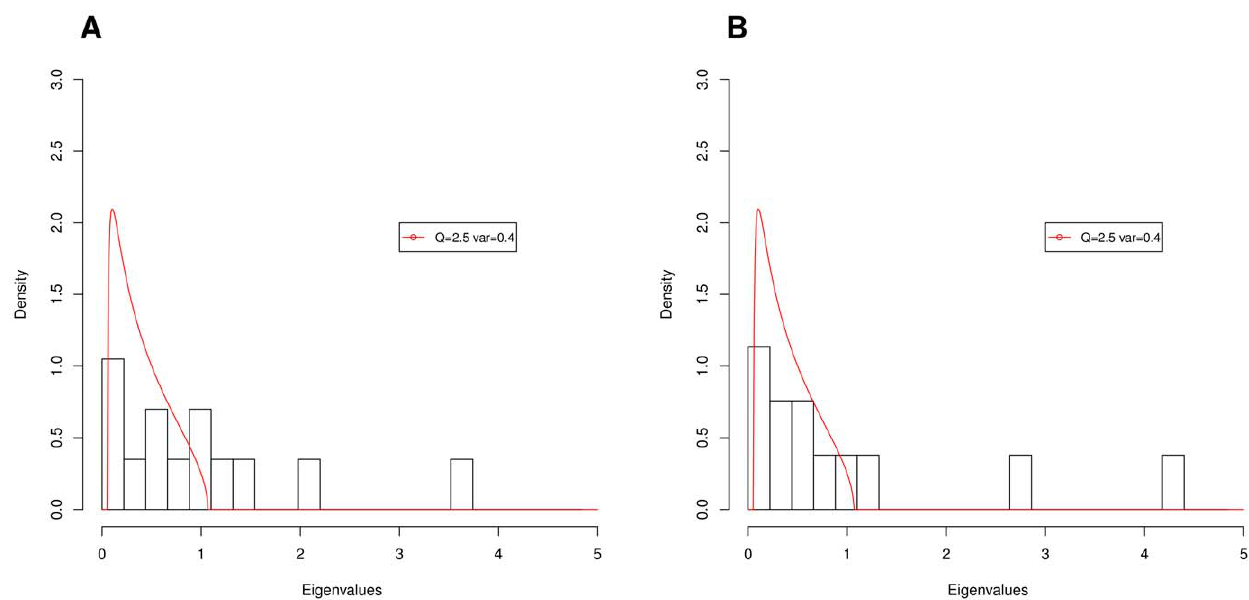
Figure 2. Marcˇenko-Pastur Distribution: Long Reads Datasets. We found the Marcˇenko-Pastur that best fits the eigen-value distribution. All eigen-vectors with eigen-values under the Marcˇenko-Pastur function are considered non informative. Figure A shows the results obtained on real long read, conversely Figure B shows the results obtained on simulated long reads.